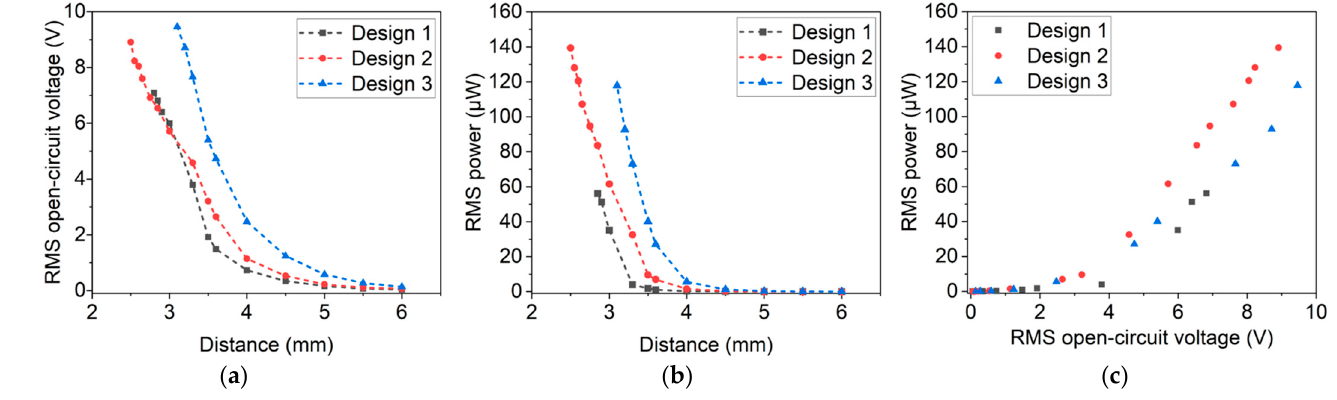
Figure 12. ( a ) Open-circuit voltage and ( b ) power output with respect to distance between harvester and excitation magnets. ( c ) Overview of achieved RMS open-circuit voltage and RMS power output at optimal load for the different harvester designs. (The different designs are introduced in Section 3).